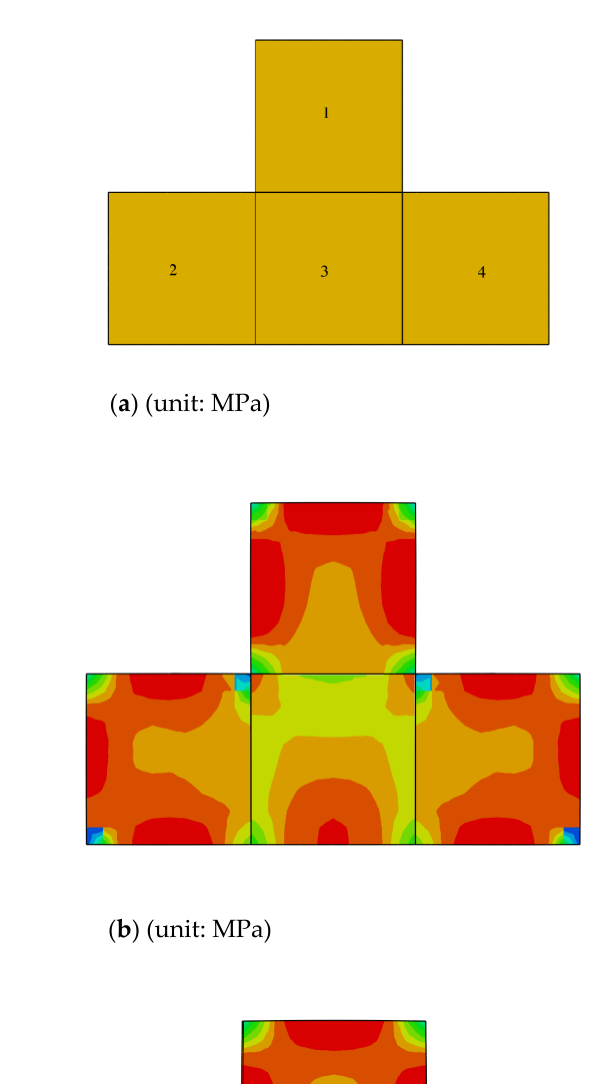
( d ) (unit: mm) Figure 11. Deformation diagram of the finite element model. ( a ) Front view in the transverse direction, ( b ) back view in the transverse direction, ( c ) front view in the longitudinal direction, and ( d )